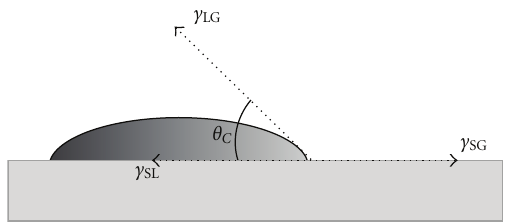
Figure 1: An illustration of the sessile drop technique with a liquid droplet partially wetting a solid substrate: θ C : equilibrium contact angle; γ SG : interfacial tension between the solid and gas; γ SL : inter- facial tension between the solid and liquid; γ LG : interfacial tension between the liquid and gas.